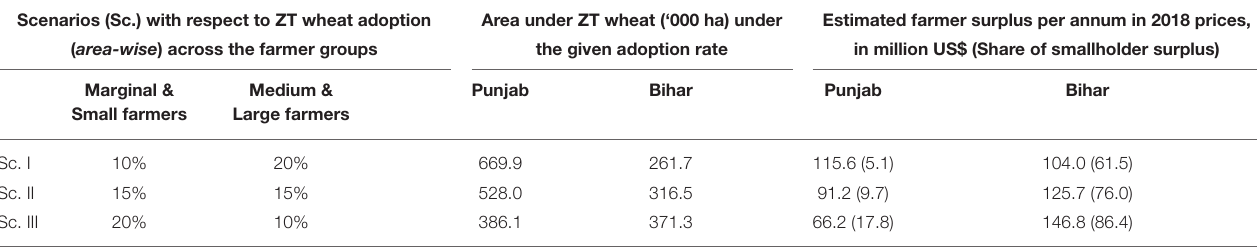
TABLE 3 | Farmer surplus under different technology targeting scenarios for ZT wheat, India. Scenarios (Sc.) with respect to ZT wheat